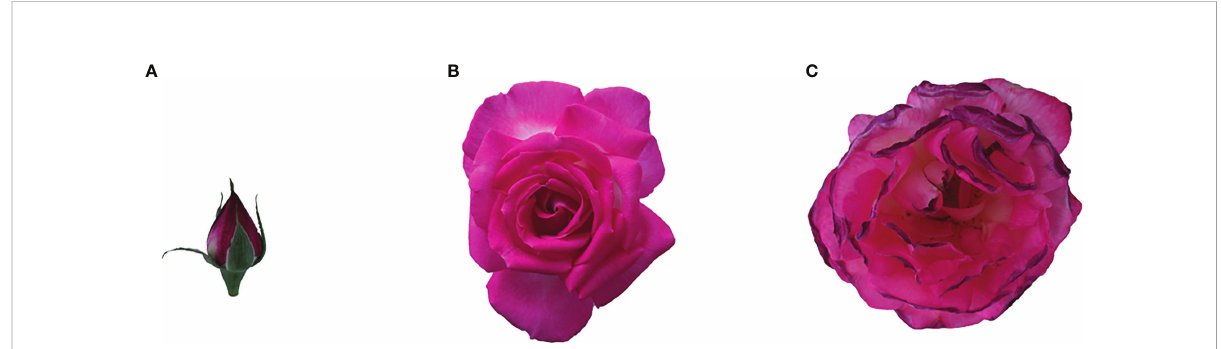
FIGURE 1 Flower developmental stages in Rosa hybrida ‘ Tianmidemeng ’ . (A) Early- fl owering (EF): sepals are unfolding, the petals are closed and become red, with almost no fragrance; (B) Semi- fl owering (SF): the outer 2-3 layers of petals are unfolded, but the petals are still closed, the color is rose-red and the aroma is strong; (C) Late- fl owering (LF): petals begin to wilt and the color begins to fade, with some